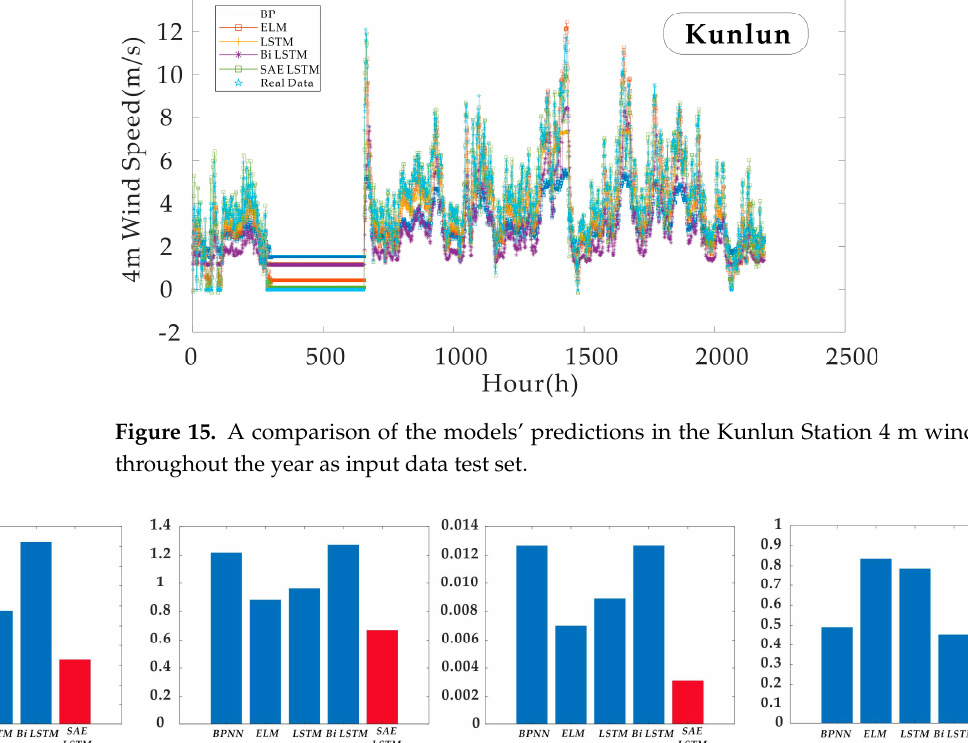
Figure 16. Comparison of statistical errors in prediction results for 4 m wind speed data at Kunlun Station throughout the year. ( a ) Five model statistical errors under the MAE criterion; ( b ) Five model statistical errors under the MAPE criterion; ( c ) Five model statistical errors under the RMSE criterion; ( d ) Five model statistical errors under the NSE